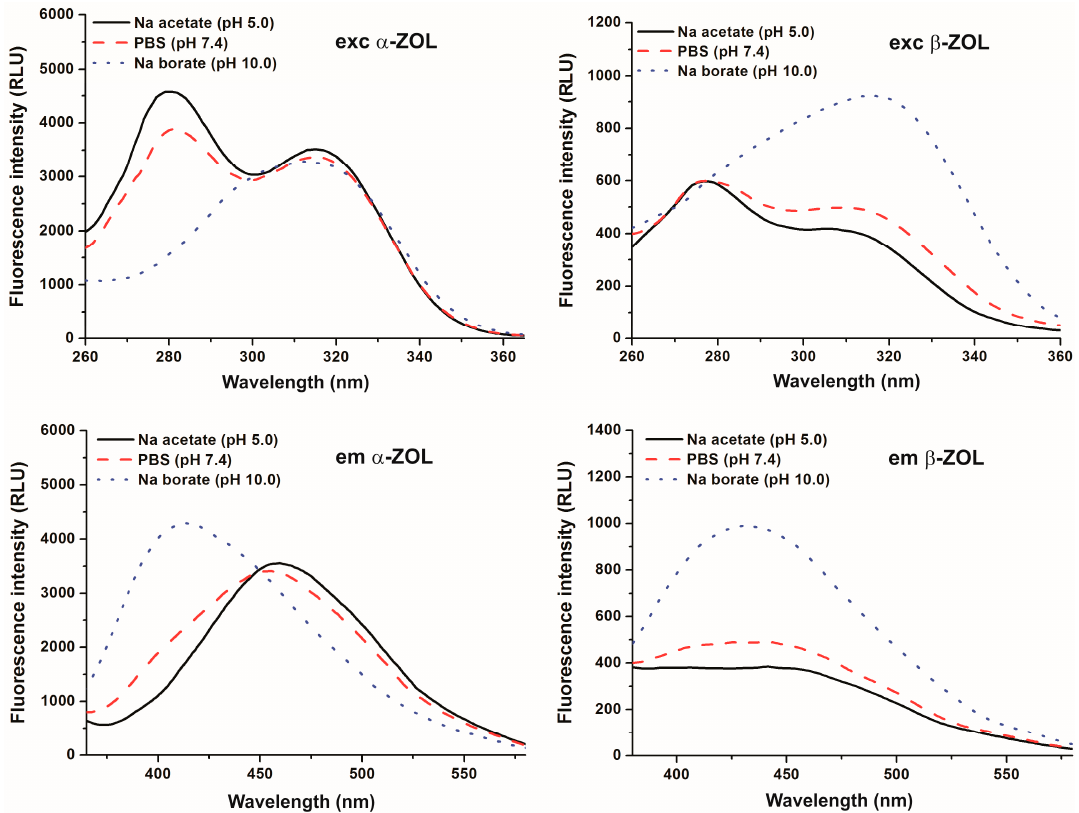
Figure 2. Fluorescence excitation ( top ) and emission ( bottom ) spectra of 20 µ M α -ZOL ( left ) and 20 µ M β -ZOL ( right ) in 0.05 M sodium acetate (pH 5.0), PBS (pH 7.4), and 0.05 M sodium borate (pH 10.0) buffers ( λ exc = 315 nm; λ em = 455 nm).